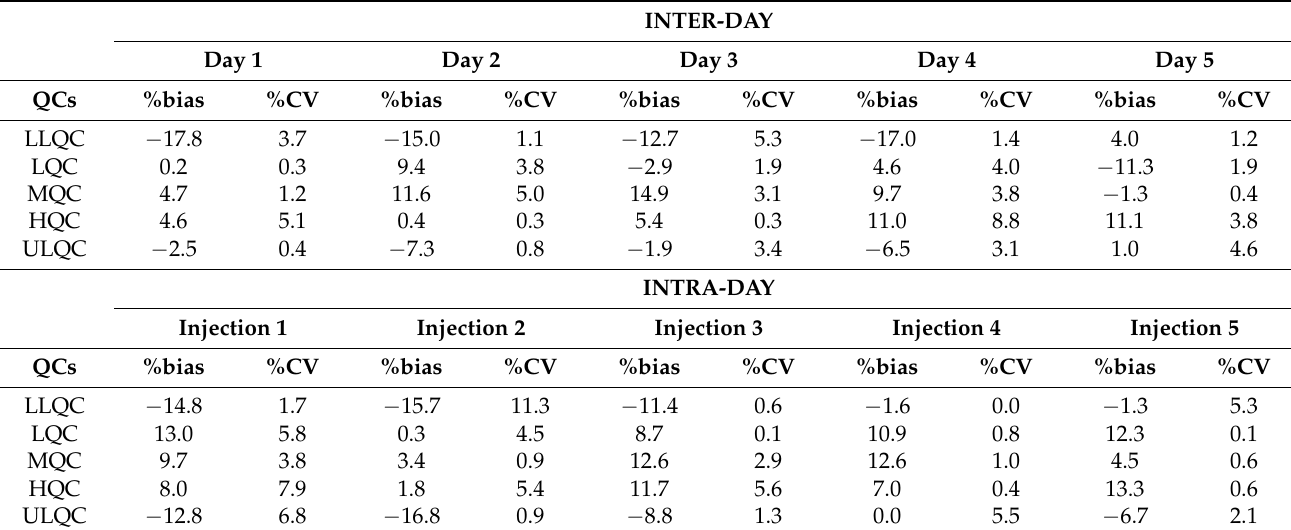
Table 1. Inter- and intra-day precision and trueness of our method in human plasma. QCs = quality